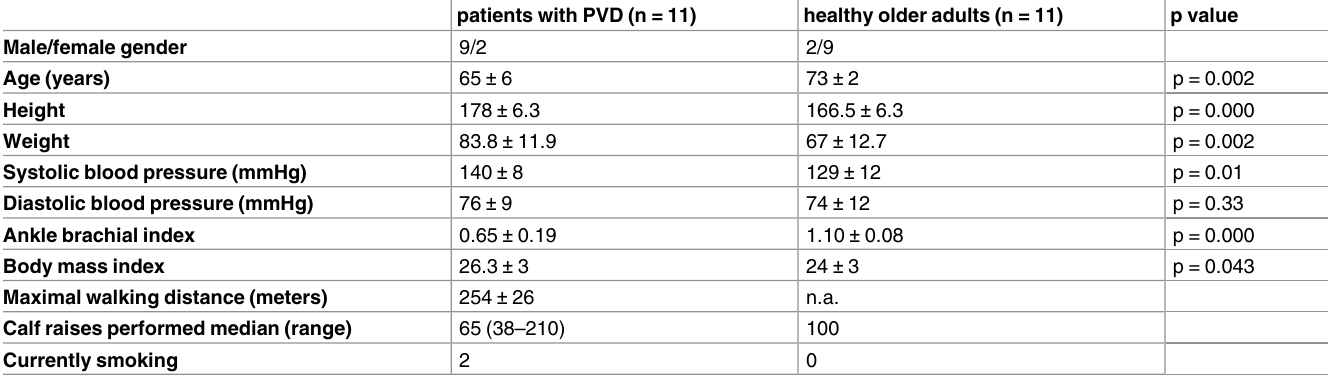
Table 1. Baseline